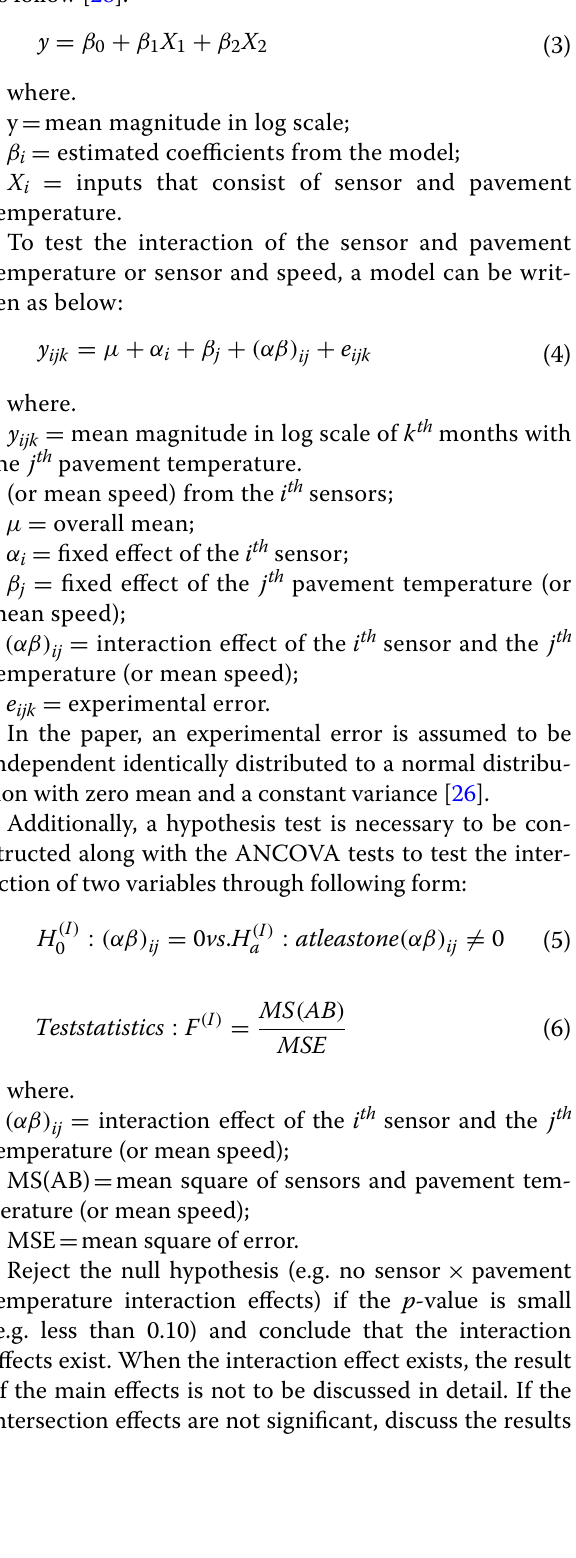
Table 2 Results of ANOVA tests on four sensors for two road sections Analysis of Variance Table